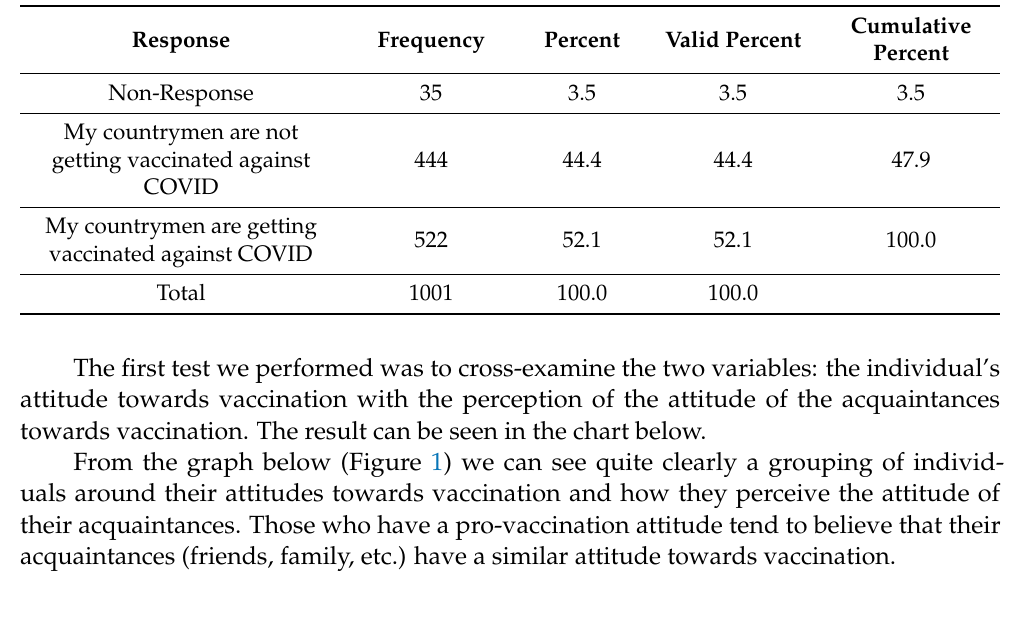
Table 4. The respondents’ perception towards COVID-19 vaccination of their fellow